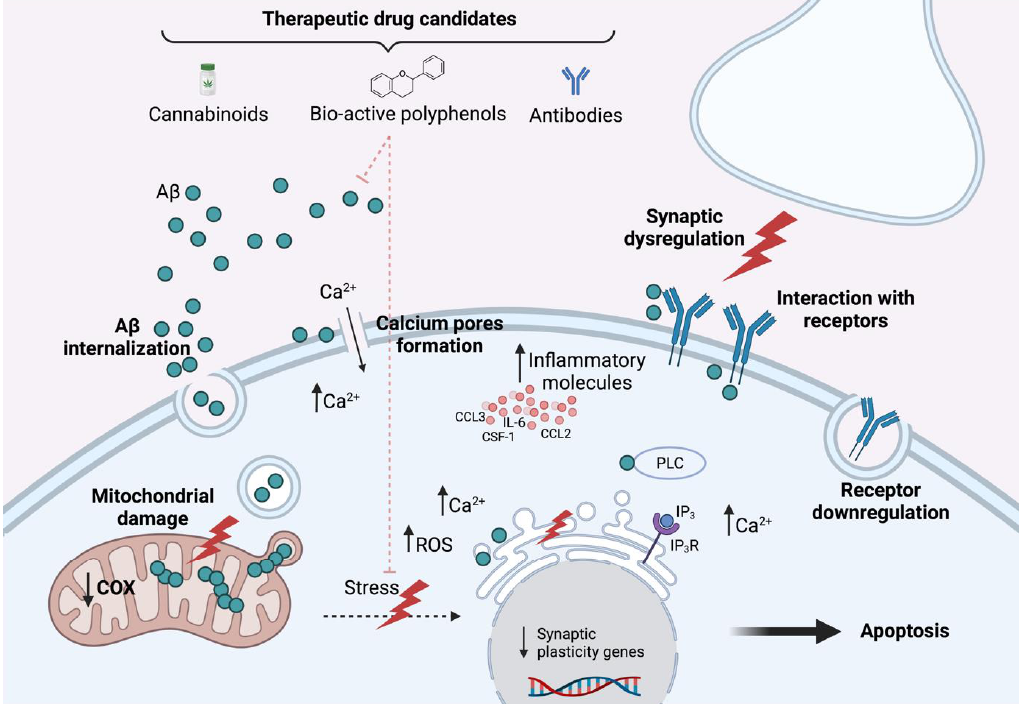
Figure 1. Uptake and effects of intracellular Aβ. While the precise mechanisms of intracellular Aβ accumulation remain unknown, recent reports indicate that the excessive accumulation results from internalization of extracellular Aβ via endocytosis or receptor interaction, but also mitochondrial uptake of long iAβ forms that are not secreted. Several studies have shown toxic effects on a number of cellular pathways, including calcium and synaptic dysregulation, inhibition of the ubiquitin–pro- teasome system, mitochondrial dysfunction, and activation of proinflammatory responses, resulting in cellular stress responses, and finally, apoptosis of the cell. (Created with BioRender.com). Based on previous results in transgenic mice models for iAβ accumulation [53,54], it was hypothesized that iAβ-induced BK channel suppression provokes a broadening of the action potentials enhancing Ca 2+ influx, leading to a dysregulation in Ca 2+ homeostasis and subsequent cell death (Figure 1). In their follow-up study, anti-APP or anti-Aβ-oligo- mer antibodies were found to be sufficient to reverse BK channel suppression, pointing to synergistic activity of both molecules, and driving attention to APP as a toxic agent. Inter- estingly, in order to develop a complementary approach for the investigation of the iAβ effect in Ca 2+ homeostasis, Minicucci et al. designed a mathematical model [55]. They val- idated previous results of an interaction between iAβ and PLC triggering the production of IP 3 , which forces an abnormal release of Ca 2+ from the ER after hyperactivation of IP 3 receptors [56] (Figure 1). These studies on calcium dysregulation suggested a relevant ef- fect of iAβ in neuronal excitability. 5. Impact of Intracellular Aβ on the Neuronal Architecture Fernandez-Perez et al. specifically studied the impact of Aβ oligomers in the nucleus accumbens of double (APP/PS1) transgenic mice showing an increased iAβ accumulation. The nucleus accumbens is a brain area very closely related to the main affected regions in AD (such as the hippocampus and cortex) that plays a critical role in reward, cognition, learning, and emotional behavior [57–59]. Electrophysiological recordings in dissociated neurons and brain slices showed an association between iAβ and an increase in excitabil-